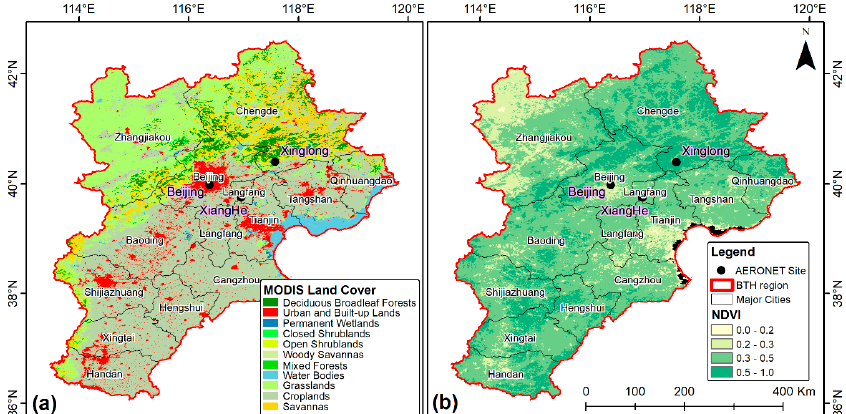
Figure 1. Land cover and yearly-averaged Normalized Difference Vegetation Index (NDVI) maps of the study area with overlaid Aerosol Robotic Network (AERONET) sites. ( a ) MODIS land cover data, ( b ) AERONET sites and NDVI values